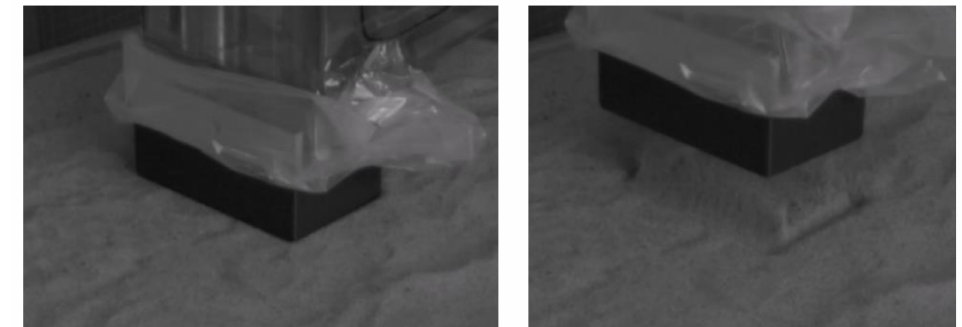
Figure 20. Jump in quartz sand with the foot in configuration